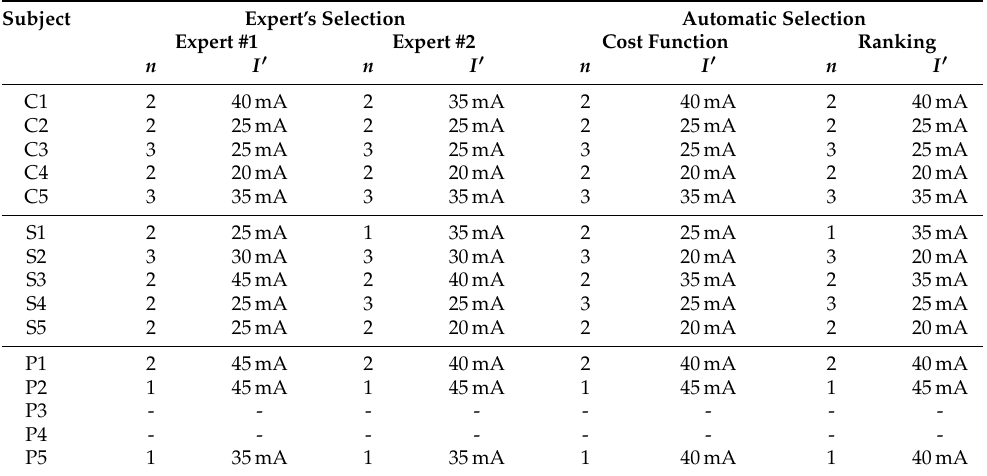
C , neurologically intact control; I (cid:48) , stimulation amplitude threshold; n , number of electrode position (cf. Figure 1A); P , individual with Parkinson’s disease; S , individual with SCI; -, no response elicited with stimulation amplitudes up to 75mA; hence, no electrode and stimulation amplitude were suggested. The stimulation amplitude for tSCS therapy is then set to 90% of the identified thresholds I (cid:48) .